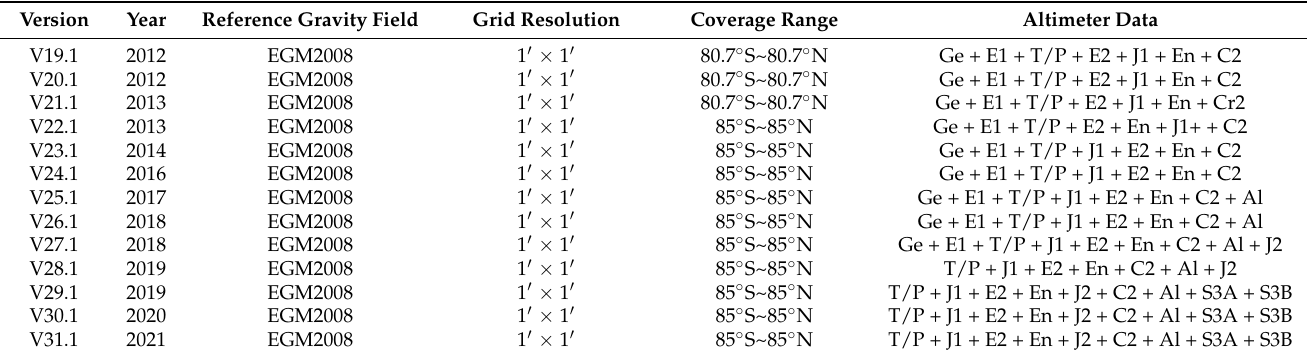
Table A2. Sandwell and Smith series global marine gravity anomaly models.